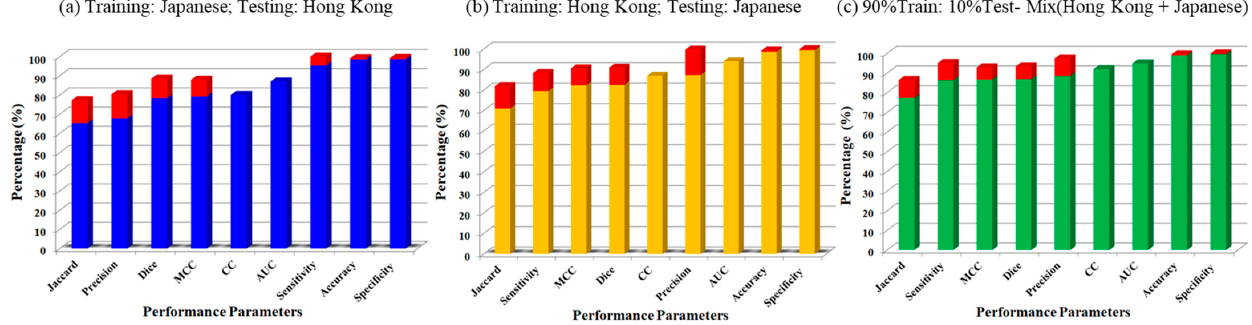
Figure 3. Bar chart for all performance parameters of Unseen AI and Seen AI